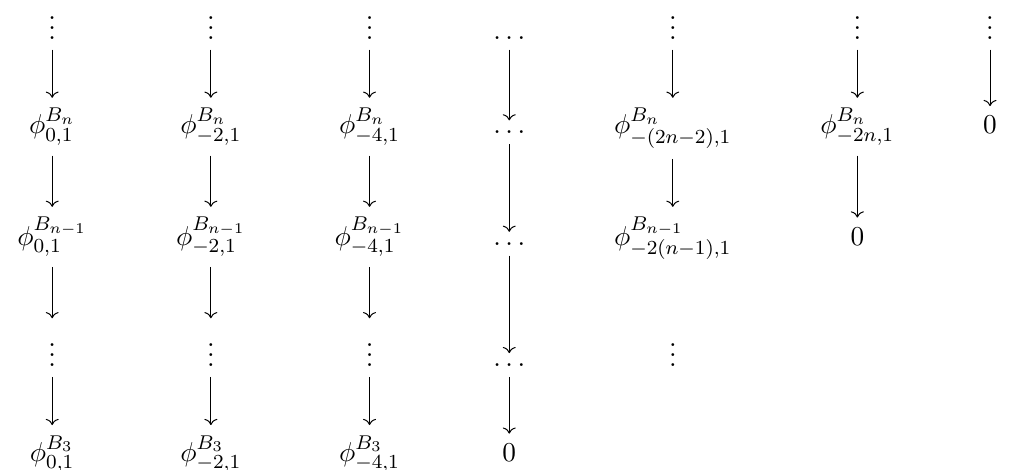
Figure 6 . Restriction of the B -series Jacobi forms. The vertical arrows correspond to setting the last coordinate to 0 and multiplying by a